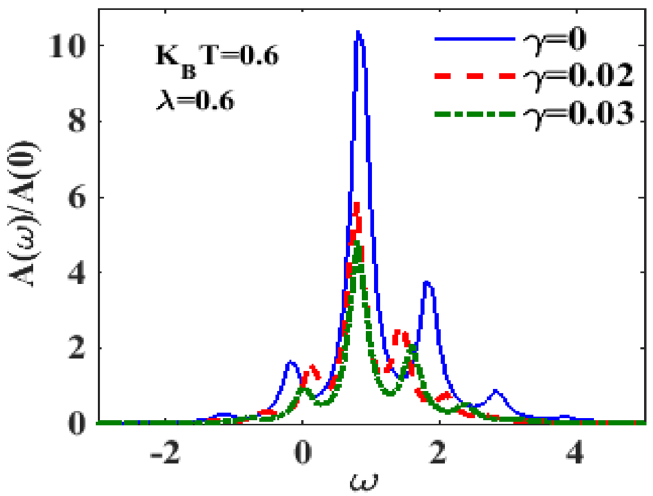
Figure 3. A (ω)/ A ( 0 ) versus ω for different values of γ at (cid:31) = 0.6, k B T = 0.6, eV b = 2.5, eV m = 0.5 .